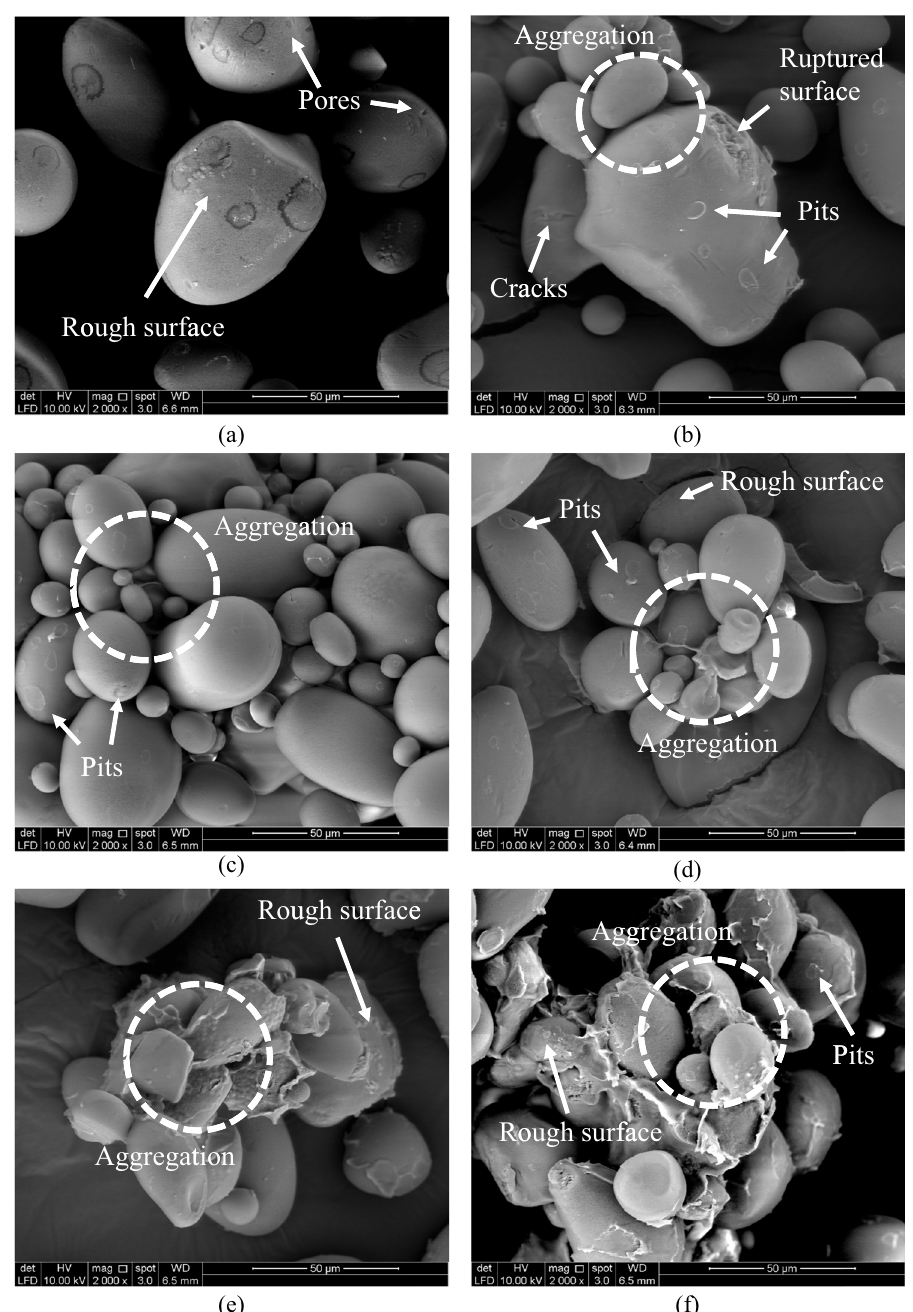
Figure 1: SEM micrographs ( 2,000 ×) of OSA starch granules where O – OSA - modi fi ed, D – dry heat treated, C – acetylated, A – acid - modi fi ed: ( a ) O, ( b ) DO, ( c ) CO, ( d ) AO, ( e ) ADO, and ( f )